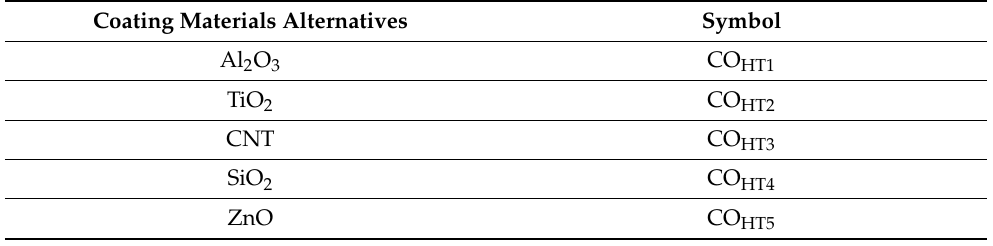
Table 12. Alternatives for coating materials.